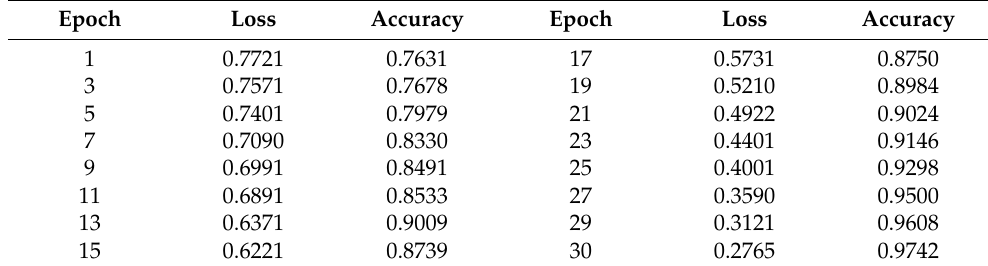
Figure 14. Loss of Alex Net model. Table 10. Loss and accuracy of the suggested model.